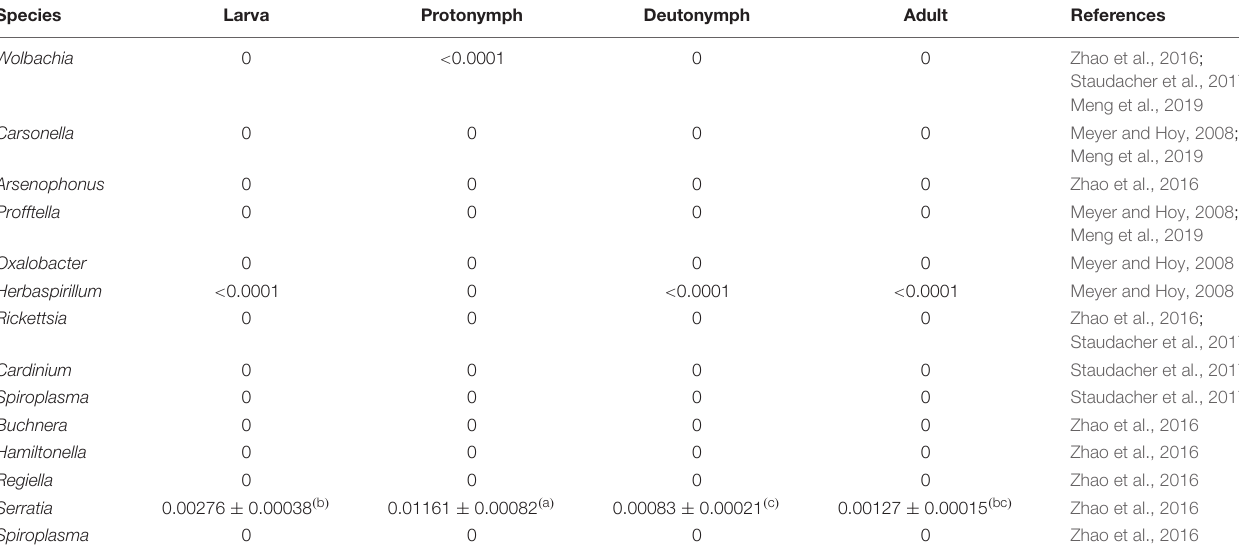
TABLE 2 | Sequencing reads of symbionts across the life stages of P. citri *.